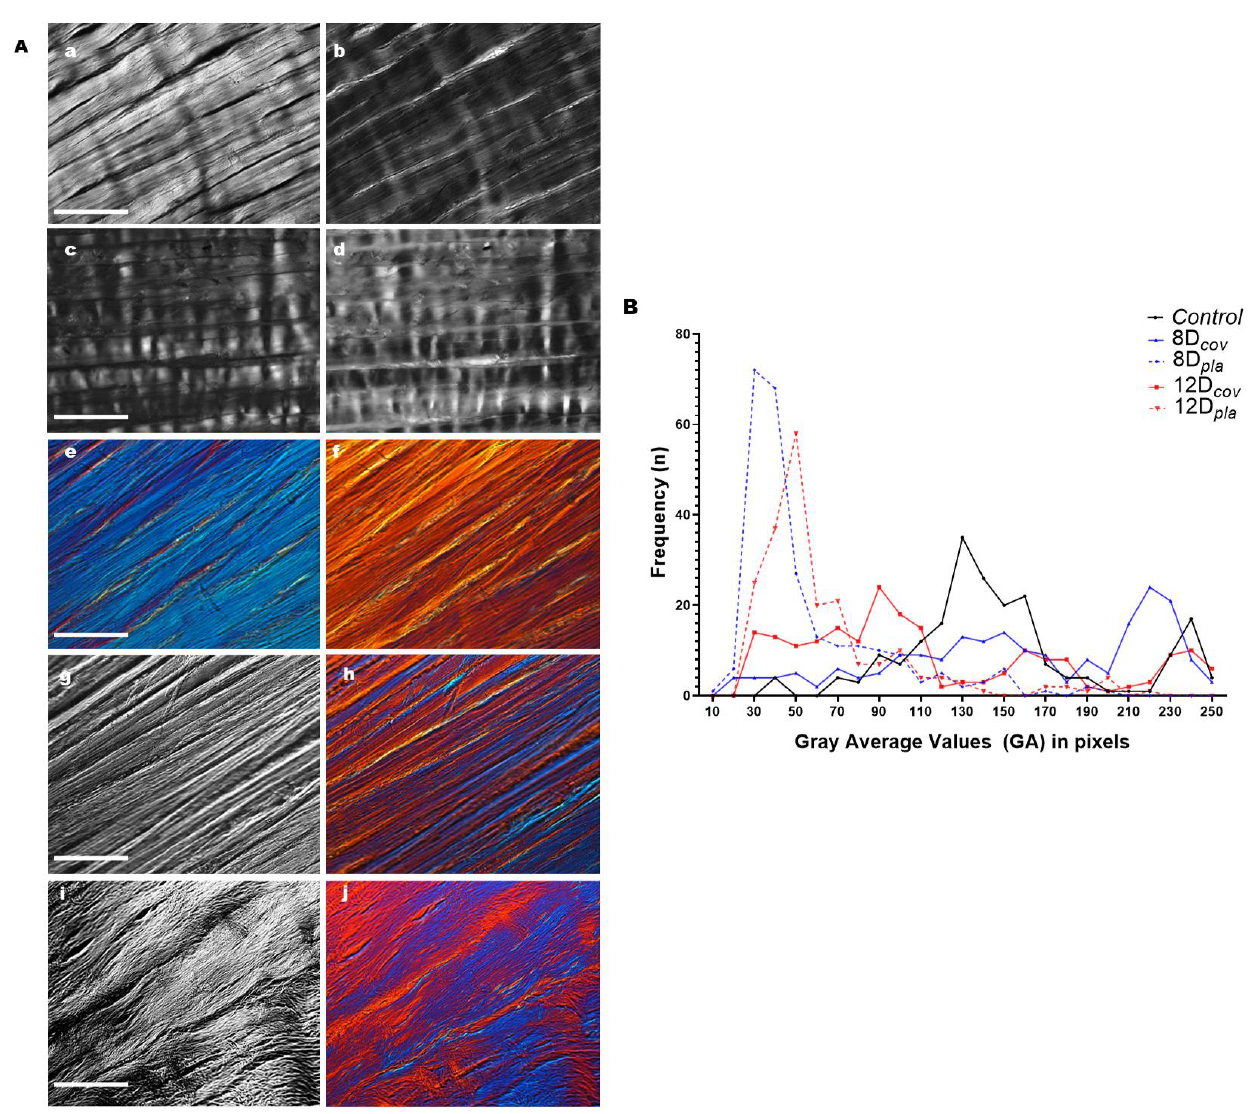
Figure 1. Birefringence images and respective average gray evaluations obtained for sections of control and cultivated rat calcaneal tendons. ( A ). Images representative of control tendon sections are shown before ( a , c , e ) and after ( b , d , f ) birefringence compensation. The intensity variations in birefringence brilliance levels are caused by variations in collagen fiber orientation with respect to the crossed polarizers. When the long axes of tendons were positioned parallel to the polarizer’s PPL, the crimp structure becomes identifiable ( c , d ). Interference colors obtained when using the DIC-PLM system are depicted for sections of control tendons ( e , f ) and for tendons cultivated on glass coverslips ( h , j ). Images ( h , j ), obtained with the DIC-PLM system, correspond to images g and i, respectively, which were obtained with ordinary polarization microscopy. Structural changes in collagen bundles were visualized with increasing time of tissue cultivation ( g , h — 8 days; i , j — 12 days). Scale bars equal 50 µm. ( B ). Polydispersed distributions of birefringence average gray values expressed in pixels corresponding to optical retardations for collagen bundles of tendon sections immersed in water. The higher frequencies of average gray values that were detected in control tendons shift to smaller values in tendons cultivated for 8 and 12 days on plastic dishes and in tendons cultivated for 12 days on glass coverslips. The long axes of the tendons were positioned at 45° with respect to the PPL.